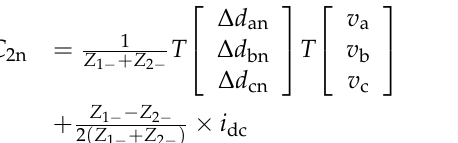
(19) According to Kirchhoff’s voltage and Kirchhoff’s current law, for the column loop equation and node voltage equation of the three-phase current source converter shown in Figure 1, when the three-phase power grid is symmetrical, the filter capacitance of the LC filter can be obtained. The potential is equal to the midpoint of the three-phase grid. Then, the mathematical model of the three-phase current source converter is trans- formed into Clarke coordinates, which are converted from the three-phase static coordi- nate system to the two-phase static coordinate system, and the system order is reduced